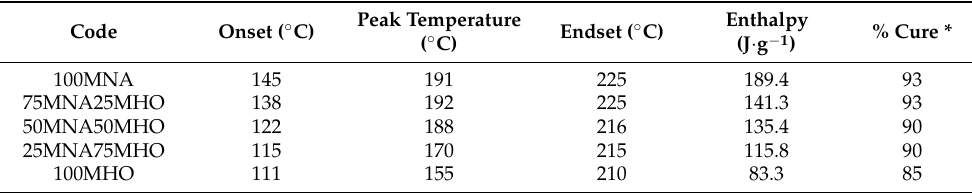
Table 3. Main parameters of the DSC test of the curing process of different samples composed of the epoxidized hemp oil (EHO) and varying contents of methyl nadic anhydride (MNA) and maleinized hemp oil (MHO).